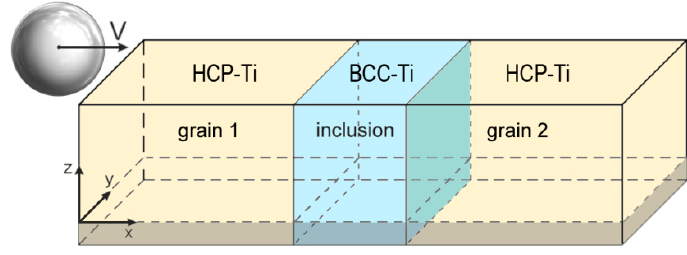
Figure 1. Molecular dynamic model of the scratch test for a HCP-Ti crystallite with inclusion of